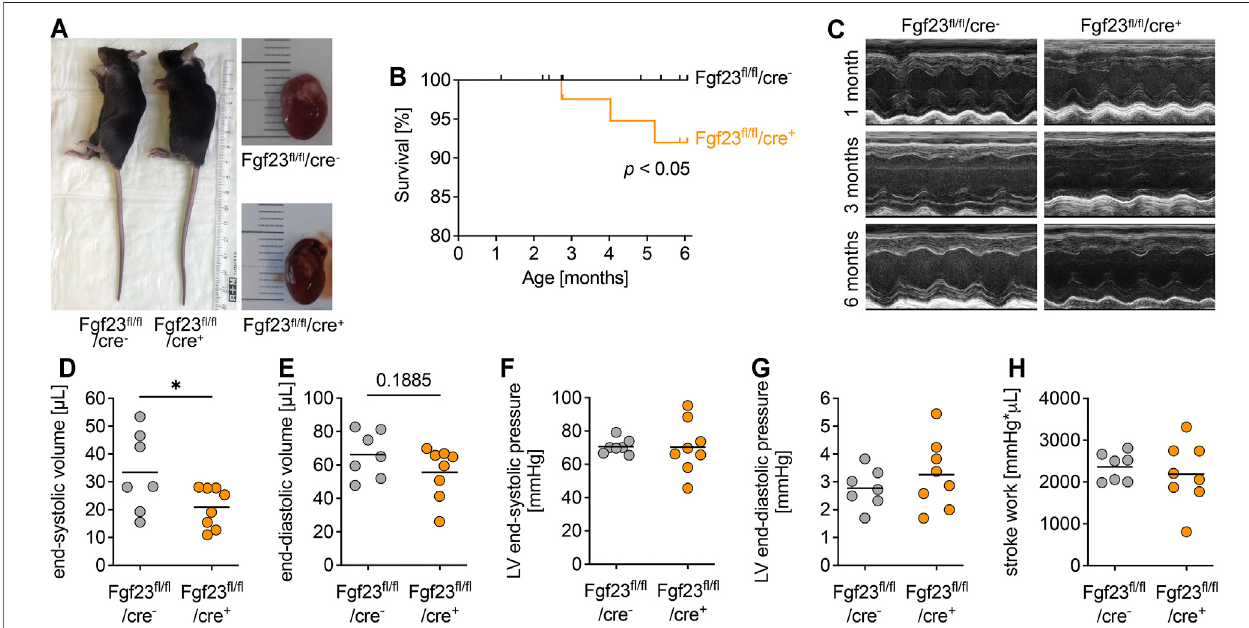
FIGURE 3 | Cardiac-myocyte speci fi c Fgf23 knockout mice do not display changes in cardiac function and geometry. (A) Body length and heart size are not different between three months old Fgf23 fl / fl /cre + and Fgf23 fl / fl /cre − control mice. (B) Fgf23 fl / fl /cre + mice have an increased mortality rate within six months of age. * p < 0.05 analyzed using Log-rank test; n (cid:2) 54 – 79 mice per genotype. (C) Representative parasternal long-axis M-mode echocardiography images of 1, 3 and 6 months old Fgf23 fl / fl /cre − and Fgf23 fl / fl /cre + mice. (D – H) Quanti fi cation of end-systolic and end-diastolic volume, end-systolic and end-diastolic pressure, and stroke work using echocardiography and Millarcatheter, respectively,in sixmonthsoldFgf23 fl / fl /cre − and Fgf23 fl / fl /cre + mice.Dataisgiven asscatter dotplots withmeans; * p < 0.05 analyzed using unpaired t -tests according to Shapiro-Wilk normality test; n (cid:2) 7 – 8 mice per